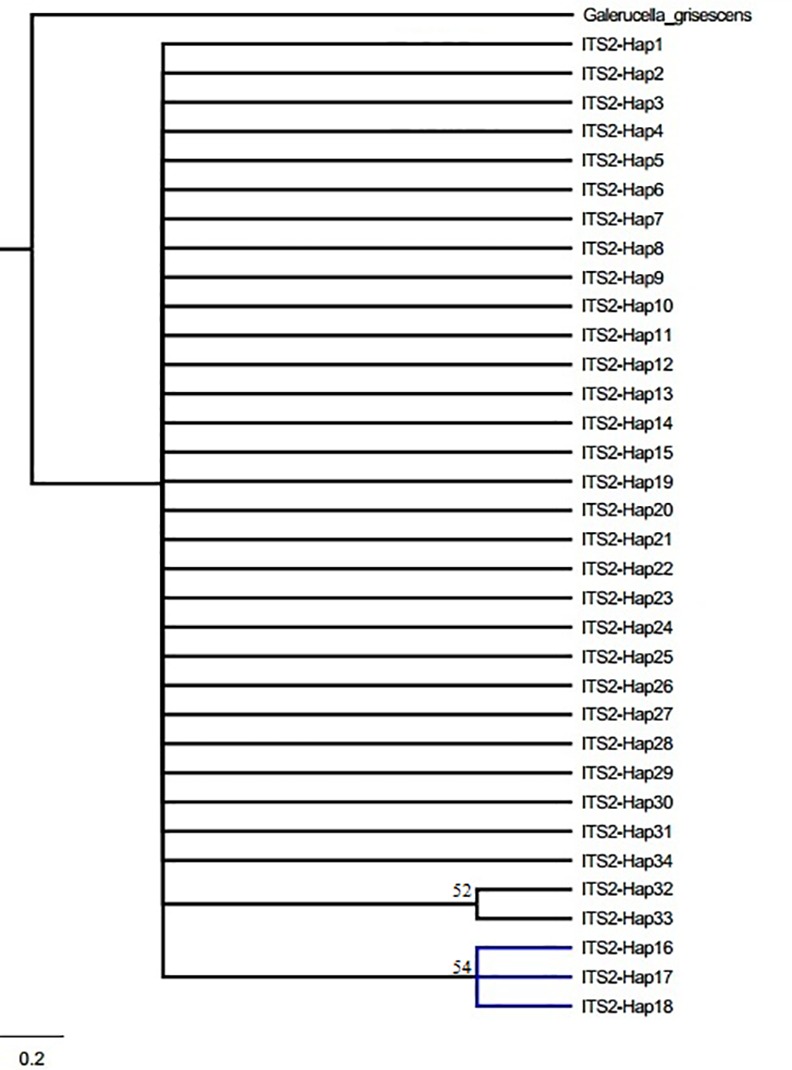
Bayesian phylograms based on ITS2 region sequences obtained from G. birmanica samples.Blue indicates haplotypes from northeastern China (NEC) region.